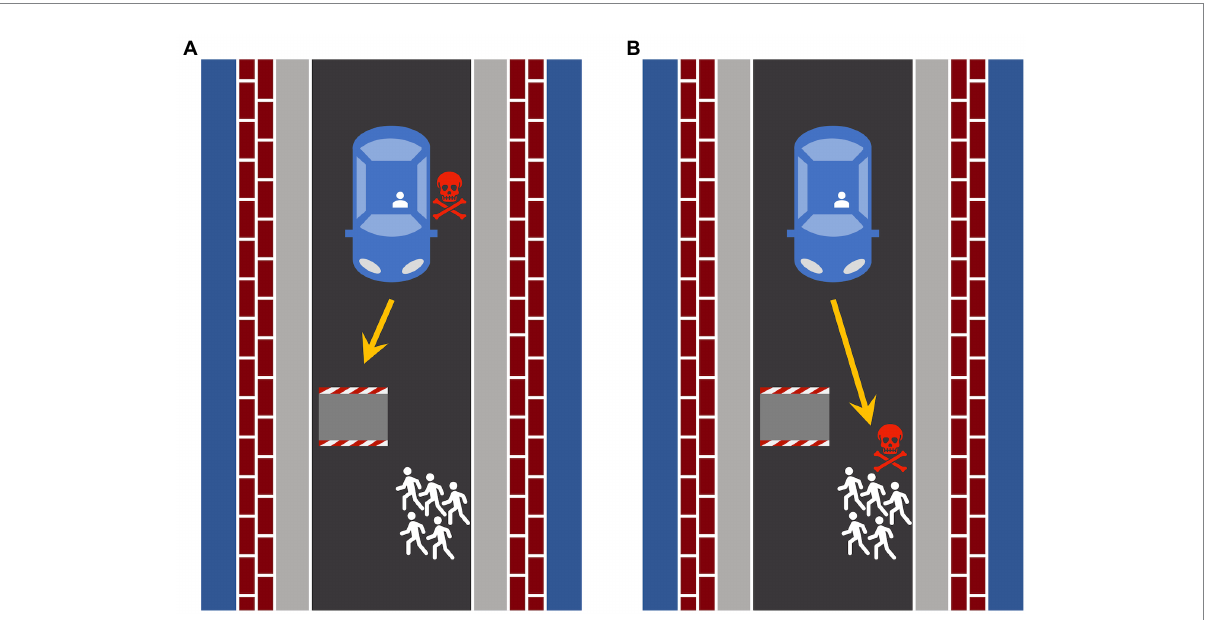
FIGURE 1 Two examples of the illustrations of the road-accident scenarios employed in the experiment. The images depict the two available actions for a road-accident scenario with five pedestrians on the road. (A) The person inside the vehicle is sacrificed to save the five pedestrians. (B) The five pedestrians are sacrificed to save the person inside the vehicle. The scenarios were created using Microsoft PowerPoint® and Apple